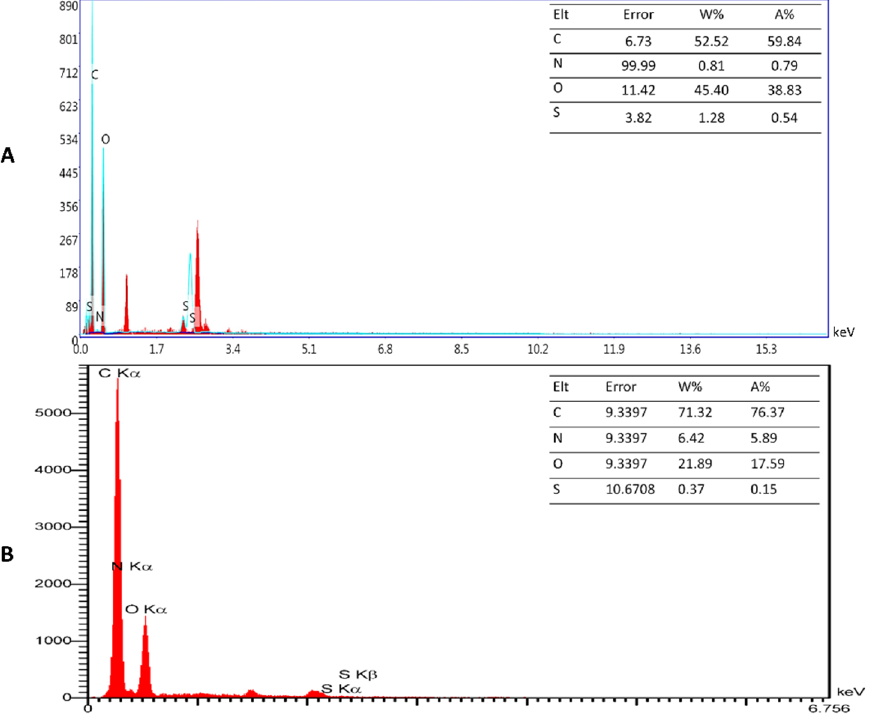
Figure 4. The EDX spectra of GO-PEG-PEN ( A ) and GO-PEG-OXA ( B ). Table 2. The EDX results for GO-PEG-OXA and GO-PEG-PEN composites.